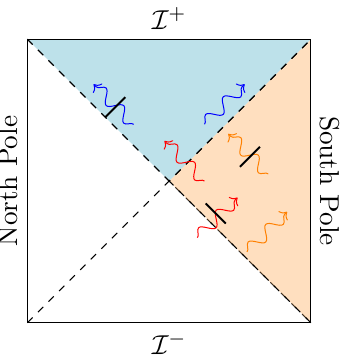
Figure 3 . Penrose diagram of the Unruh state. The black bars denote zero one-point functions, whereas the arrows denote non-zero one-point functions of the stress tensor. Globally (red radia- tion), there are only left-moving modes and no right-moving modes. In the static patch (orange radiation), this corresponds to no outgoing radiation. This gets transferred to the Milne patch (blue radiation). As also elaborated upon in the main text, in global or Kruskal coordinates there is a flux of negative